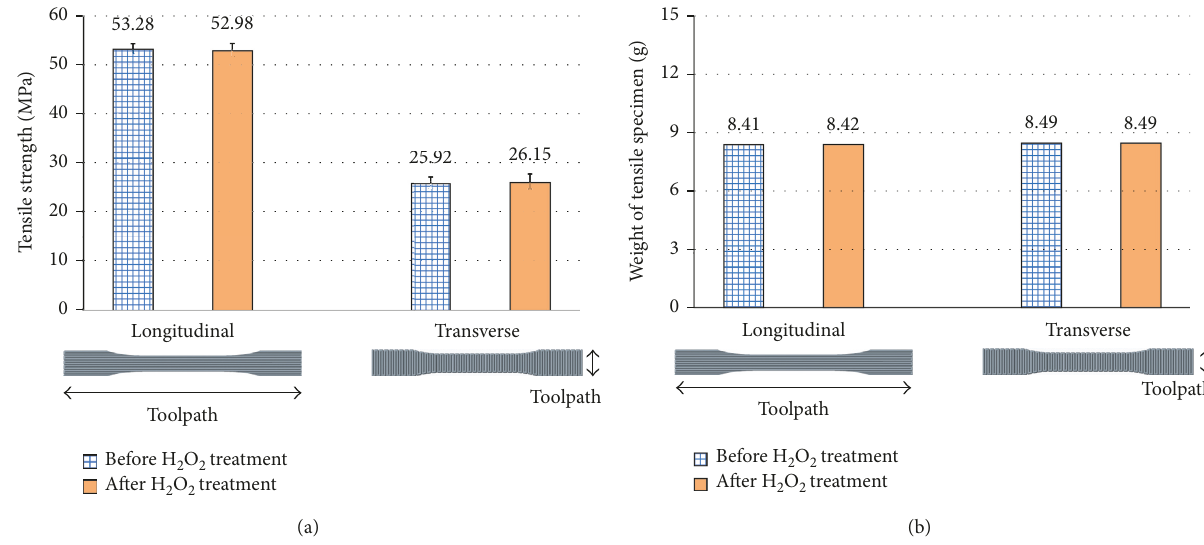
2 O 2 treatment. In the tensile tests in (a), three